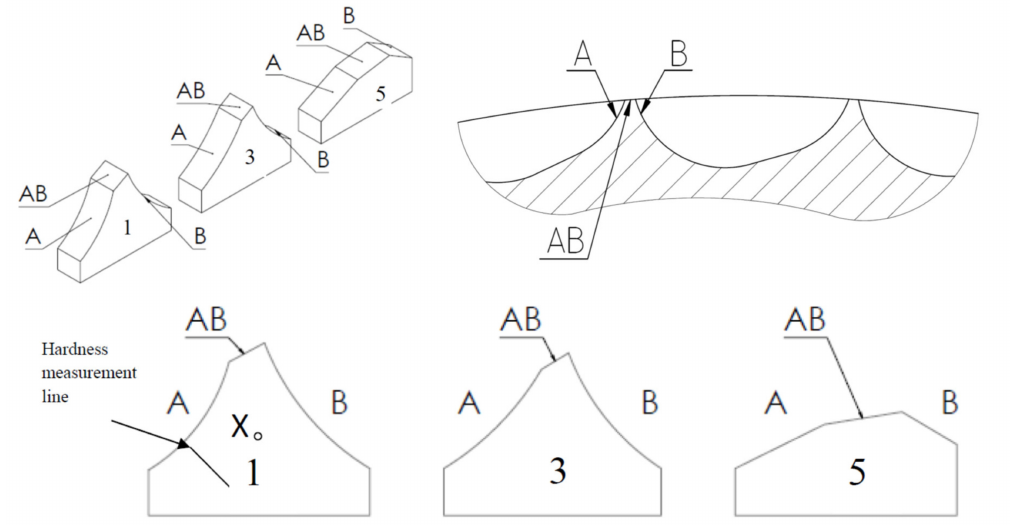
Figure 5. Scheme of samples taken from the first, third, and fifth row with a division per observation zones. ( A ) The lower side of mold; ( B ) The upper side of mold; ( AB ) The thresholds; ( X ) The point of microstructure observation.